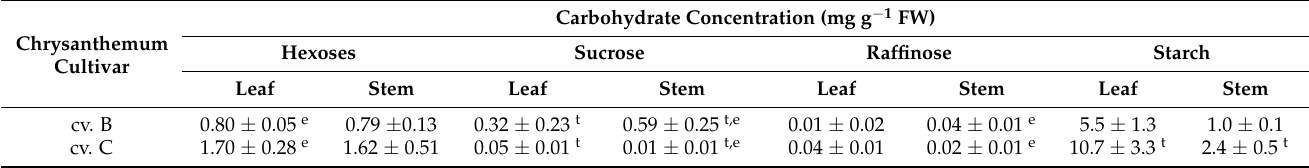
Table 4. Carbohydrate contents in pooled samples of Chrysanthemum plantlets cv. B and cv. C. Data are mean ± SD ( n = 3). Chrysanthemum